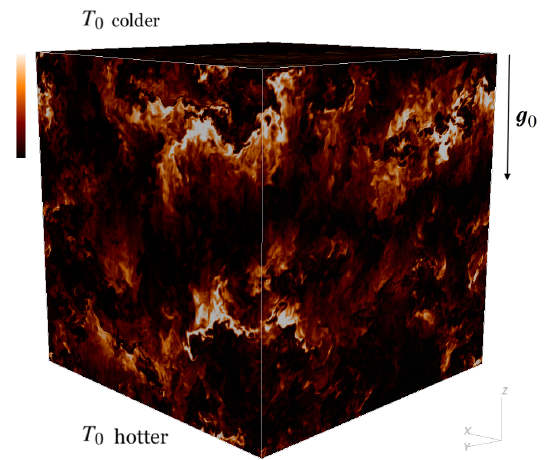
Figure 1. Visualization of thermal energy in simulation HC4 described in Table 1. The physical set-up of the simulations is also